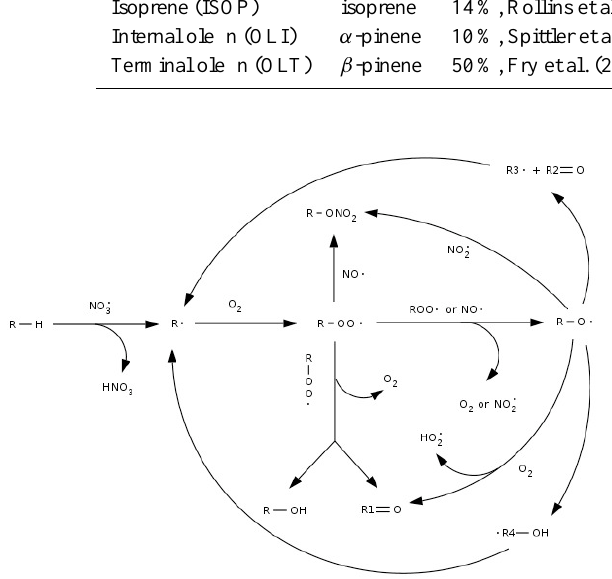
Fig. 1. Mechanism for NO 3 oxidation of an alkane.